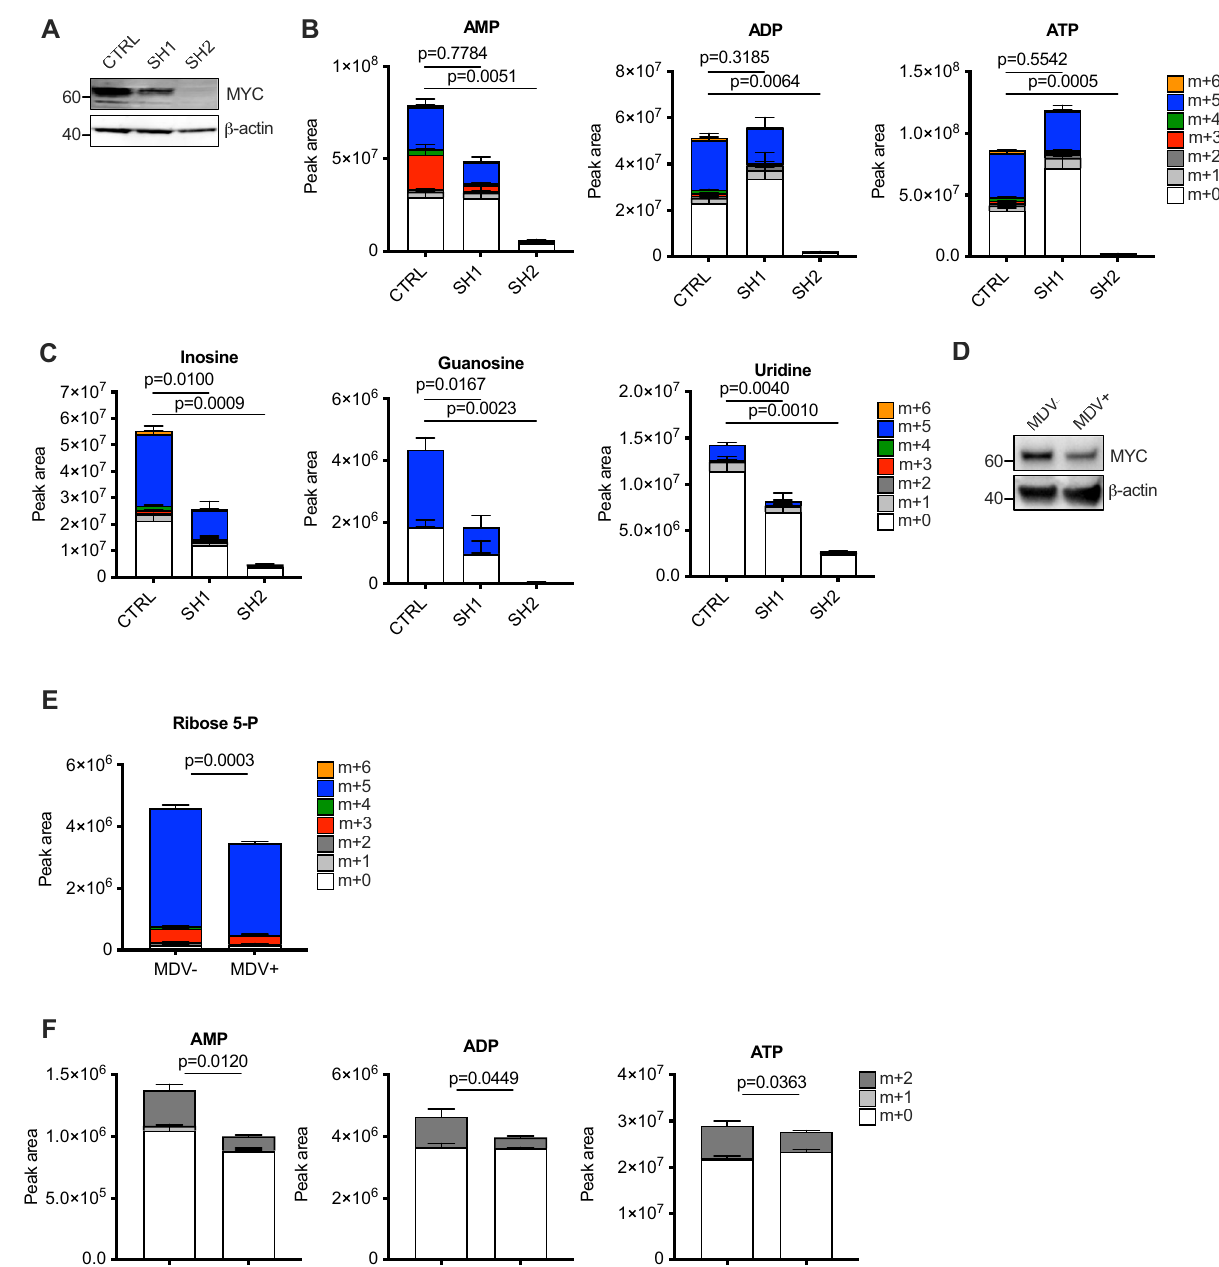
Fig. 4 | Induction of nucleotide biosynthesis, catabolism and PPP remodelling isdependent uponMYCinMYC-drivencancer cells. LC-MSwasused toquantify isotopologues of metabolites following 13 C 6 -glucose pulse in RAJI Burkitt ’ s lym- phoma ( A – C ) and Myc-caP mouse prostate cancer cells ( D – F ). A Western blot showing shRNA-mediated knockdown of MYC in Raji cells. B , C Incorporation of 13 C 6 -glucose with a 6h pulse into ( B ) adenine nucleotides and ( C ) nucleosides. An ordinary one-way ANOVA was used to determine statistical signi fi cance for the m+5 isotopologue ( n =3 biological replicates). D Western blot showing reduction